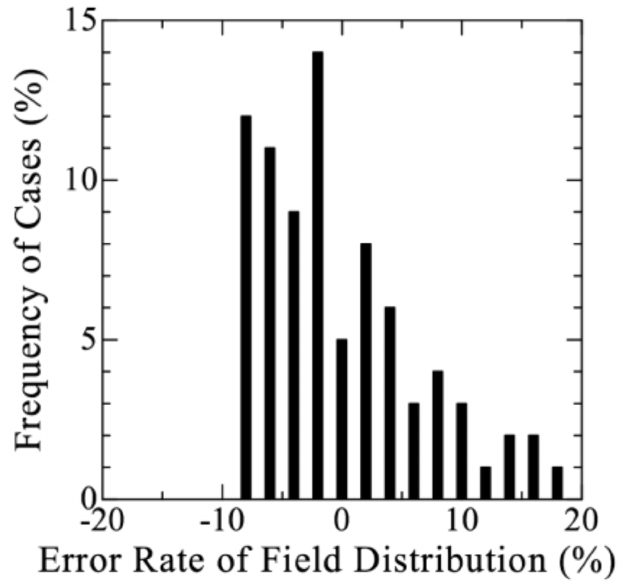
Figure 10. Histogram of the estimation accuracy of the electric field against the Laplace field evaluated for 81 waveforms obtained under the V L